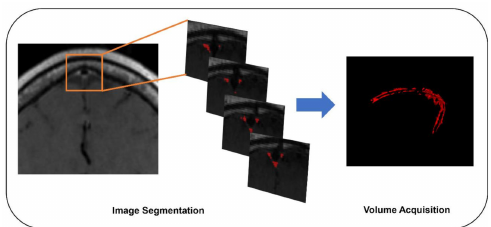
Figure 3. Segmentation workflow of peri-sinus lymphatic space using coronal T1-weighted black-blood